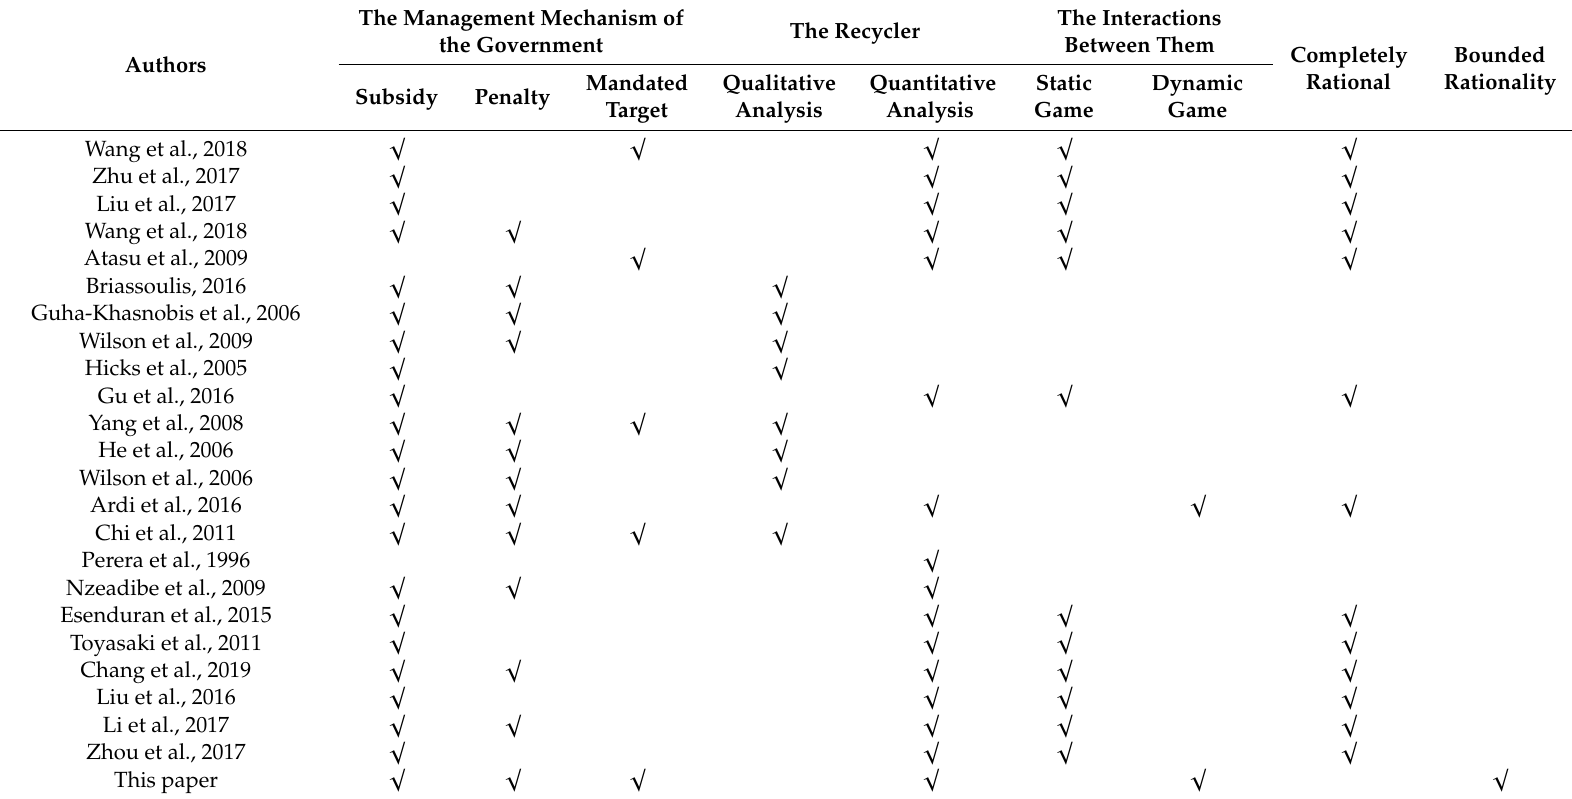
Table 1. Summary of the representative existing